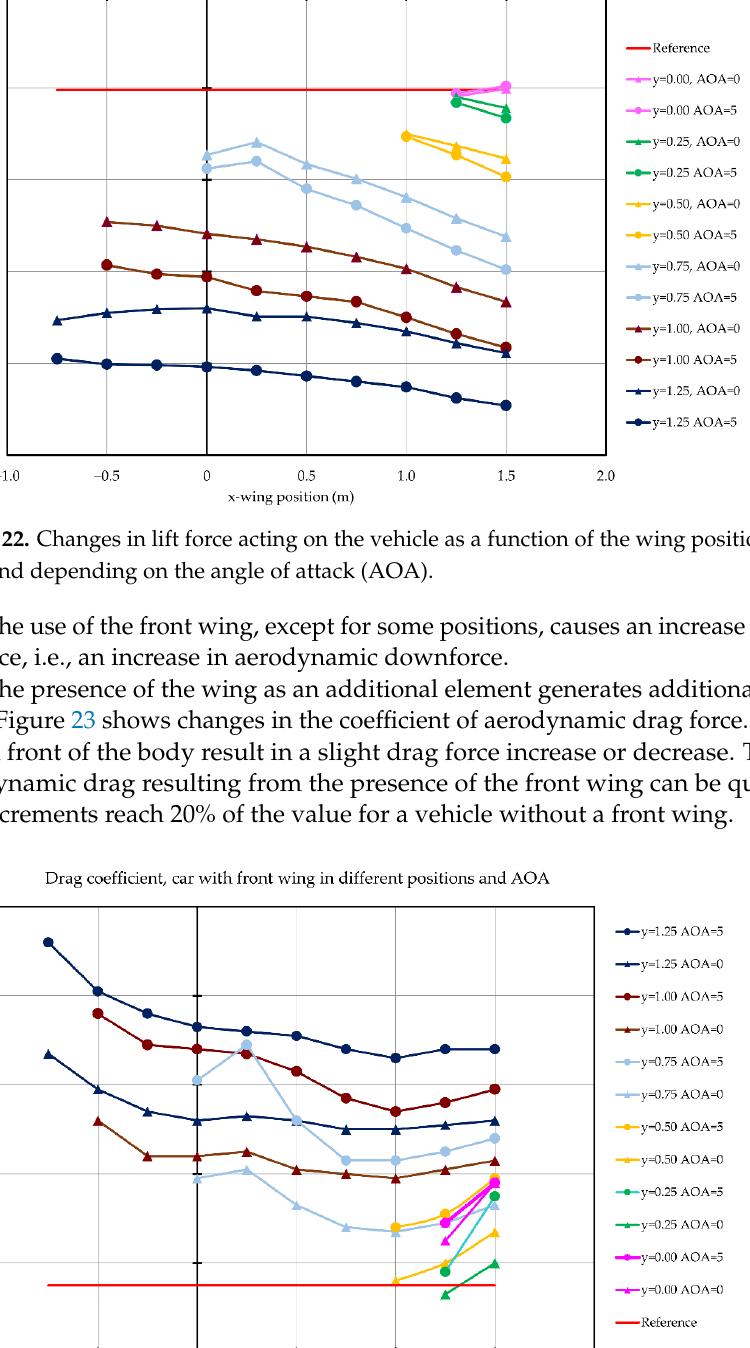
Figure 21. Increases in front wheel aerodynamic downforce coefficient as a function of the angle of attack and wing position in relation to the car body: ( a ) AOA 0 degrees; ( b ) AOA 5 degrees; ( c ) AOA 10 degrees; ( d ) AOA 15 degrees.